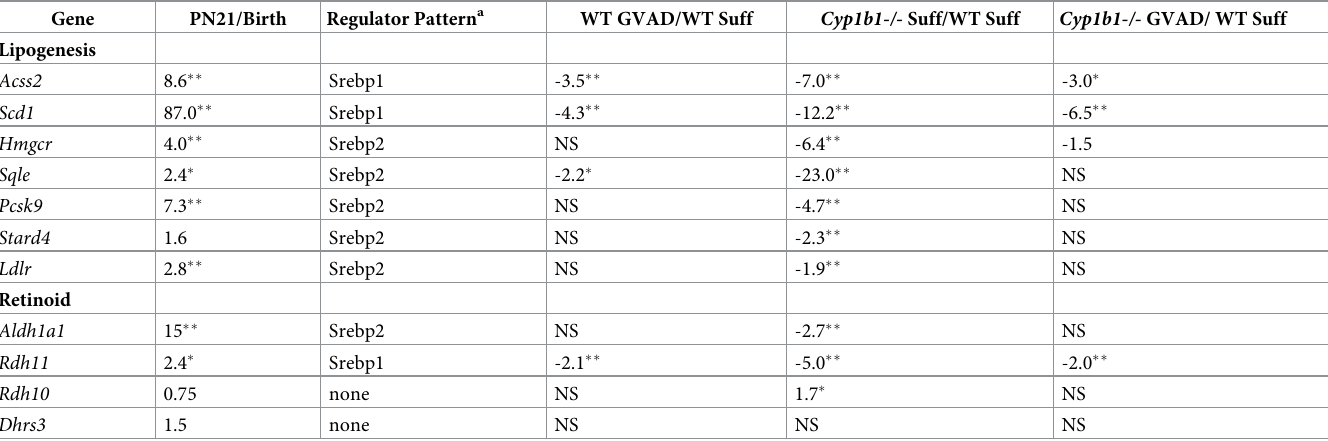
Negative sign indicates upper condition is suppressed.